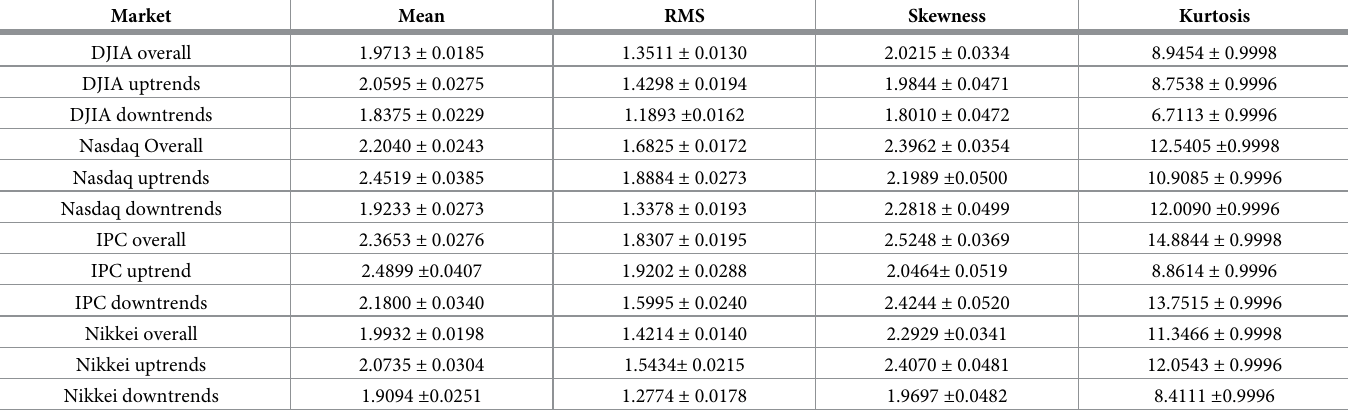
Table 6. Descriptive statistics of data presented in Tables